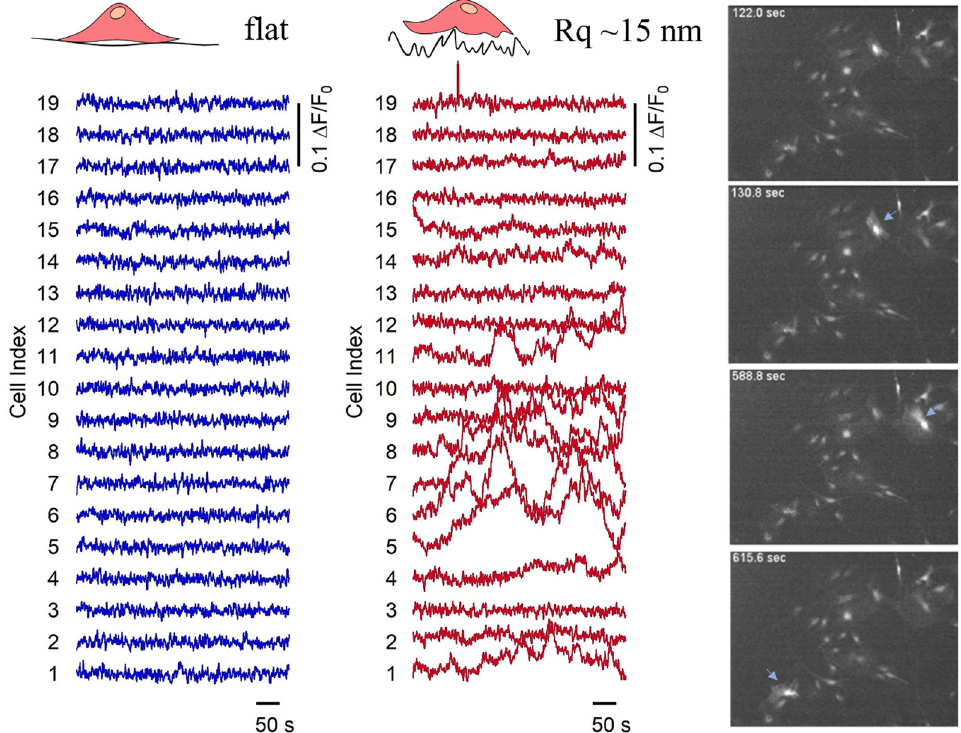
Figure 4. Calcium intensity traces ( Δ F/F) of cells cultured on homogeneous zirconia samples, as a function of time, representing spontaneous activity of cells. Blue and red lines correspond to the traces acquired on flat and nanostructured (Rq~15 nm) zirconia thin film, accordingly; the videos they are extracted from are reported in Supplementary Materials (Videos S1 and S2). On the right are representative snapshots of time-lapse videos recording spontaneous calcium activity of astrocytes cultured on 15-nm-rough zirconia substrate; light-blue arrows stress new calcium activity events.